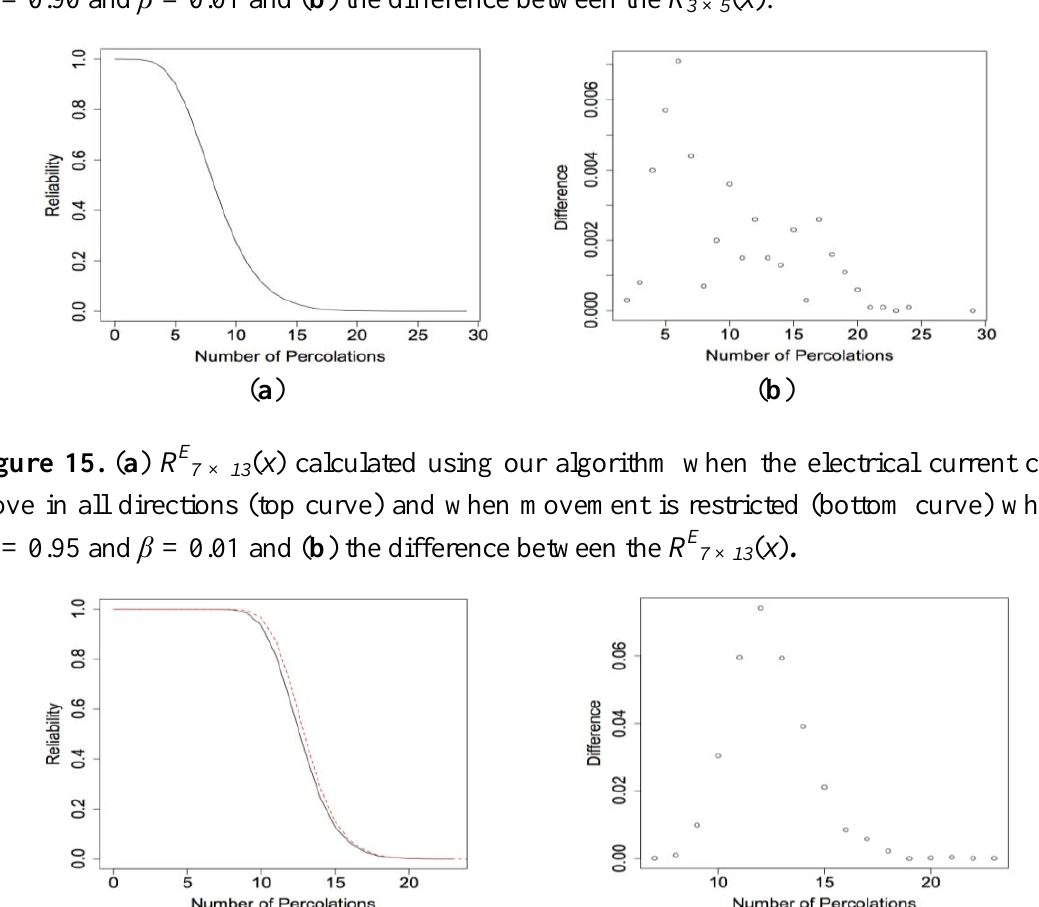
p = 0.98 and β = 0.005 and ( b ) the difference between the R H 1